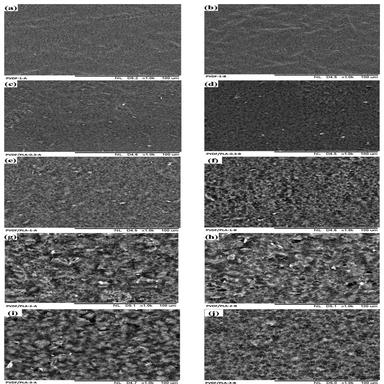
SEM outer surface images of membrane with zero (left) and 8-cm (right) air gap, (a,b) PVDF membrane, (c,d) PVDF/PLA-0.3 membrane, (e,f) PVDF/PLA-1 membrane, (g,h) PVDF/PLA-2 membrane and (i,j) PVDF/PLA-3 membrane.